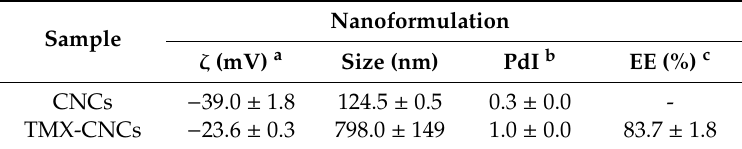
Table 1. Dynamic light scattering (DLS) / Zeta potential of CNCs and TMX-loaded CNCs (mean ± SD, n = 3).